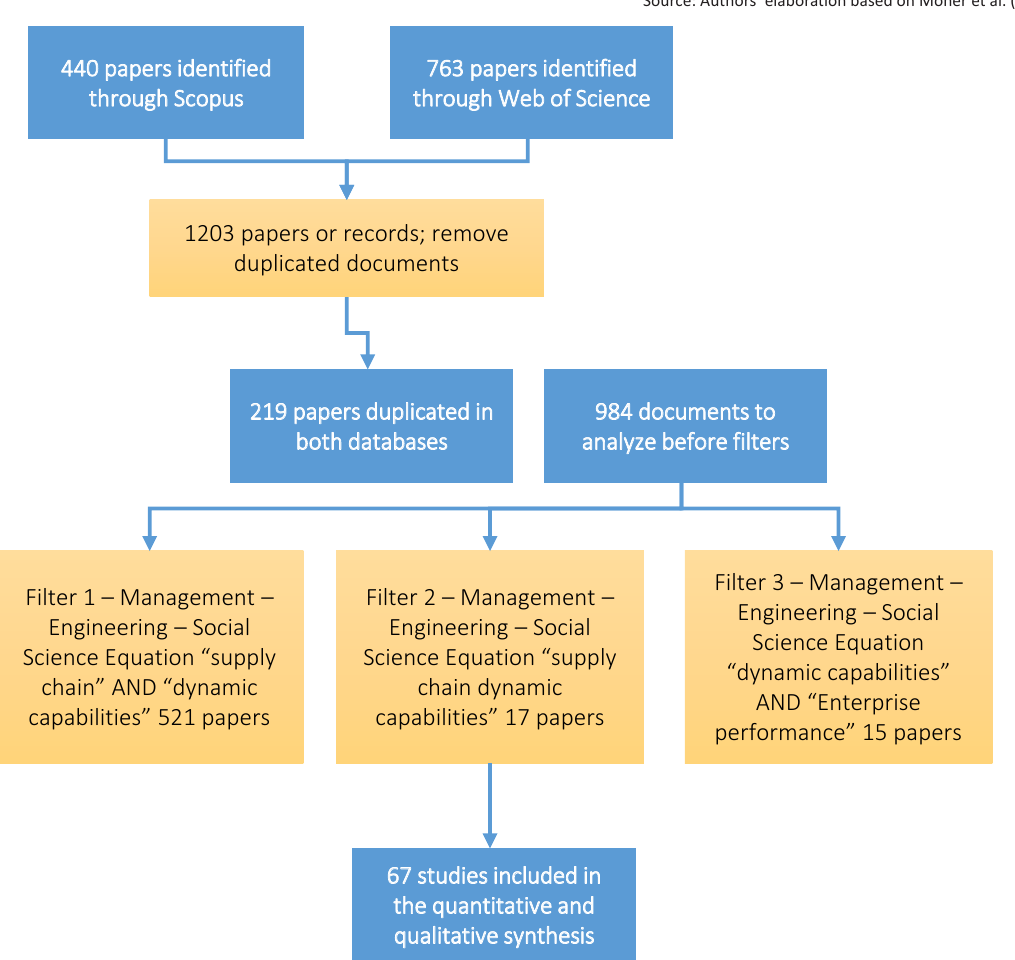
Figure 3. Information flow during the phases of meta-analysis